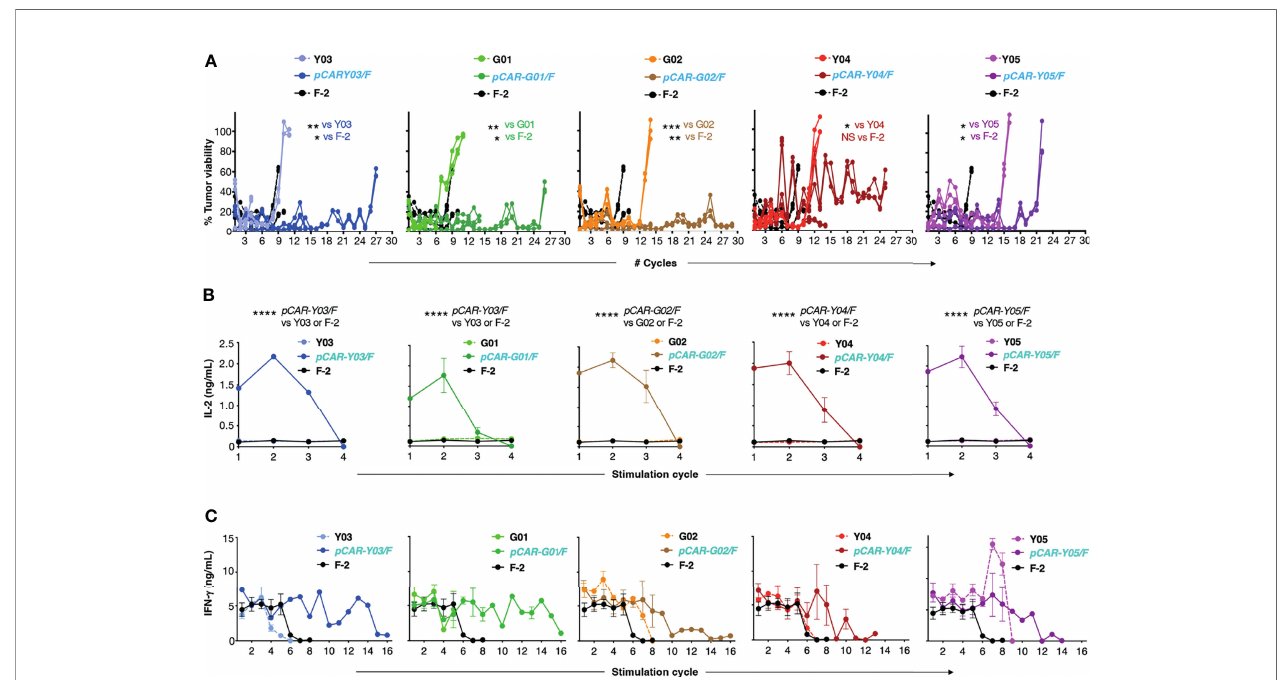
FIGURE 5 | Re-stimulation of CD19-targeted CAR and pCAR T-cells. (A) T-cells were engineered to express the indicated CARs or pCARs. 1x10 5 of the indicated transduced CAR or pCAR T-cells were co-cultivated in triplicate in a 1mL volume with an equal number of LO68-CD19 + tumor cells. After 72h, T-cells were transferred to a fresh monolayer of CD19 + LO68 cells and viability of the original tumor monolayer was determined by MTT assay. Plots indicate tumor cell viability at each stimulation cycle. Cultures were terminated when tumor cell killing was <60% or if T-cells could not be recovered. Statistical analysis was performed using an unpaired Student ’ s t test comparing the number of stimulation cycles achieved by each pCAR compared to the indicated CAR. Supernatant was collected 24h after the initiation of each stimulation cycle and was analyzed by ELISA for IL-2 [mean +/- SEM, n=2; (B) ] or IFN- g [mean +/- SEM, n=6; (C) ] (mean +/- SEM of duplicate independent cultures). Statistical analysis was performed using two-way ANOVA. **** p= < 0.0001; *** p= ≤ 0.001; ** p= ≤ 0.01; * p <